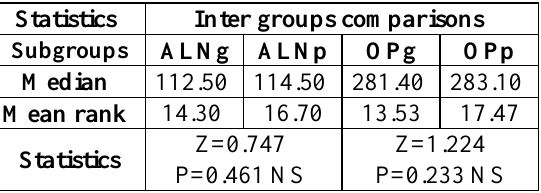
Table 7: Inter group comparisons of salivary TNF-α